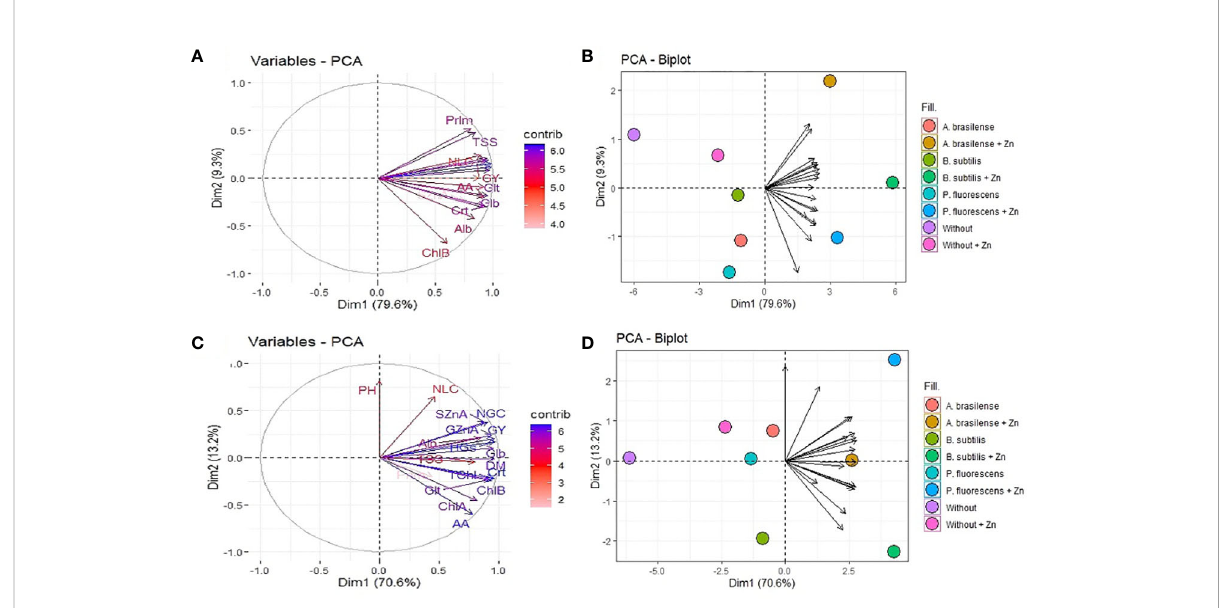
FIGURE 8 Loadings and biplot graphics of principal component analysis among the relationship of plant growth-promoting bacteria and foliar nano-zinc oxide applications for growth, nutritional, yield, and biochemical attributes of maize in the 2019 – 20 (A, B) and 2020 – 1 (C, D) cropping seasons. PH, plant height; DM, shoot dry matter; NLC, number of row per cob; NGC, number of grains per cob; HGs, 100-grains weight; GY, grain yield; SZnA, shoot Zn accumulation; GZnA, grain Zn accumulation; ChlA, chlorophyll a; ChlB, chlorophyll b; TChl, total chlorophyll; Crt, carotenoids; AA, free amino acids; TSS, total soluble sugar; Alb, albumin; Glb, globulin; Glt, glutelin; and Prlm,